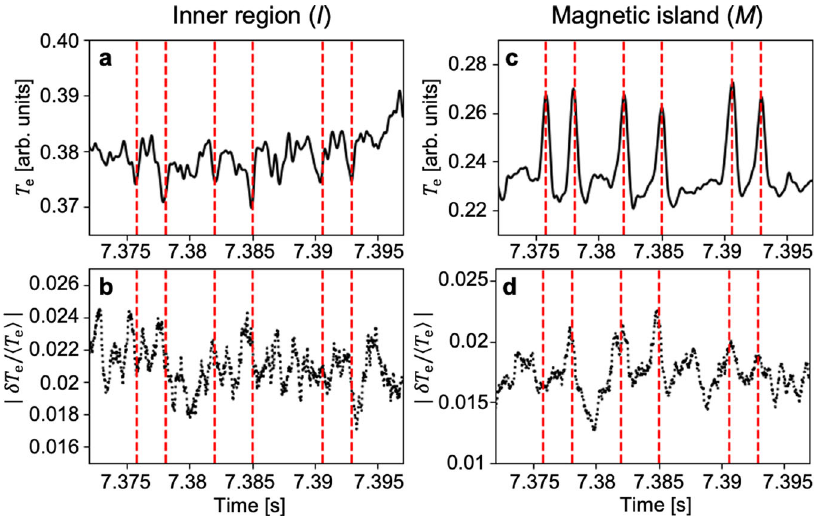
Fig. 4 Turbulence spreading into a magnetic island. a – d Low-pass fi ltered T e measurements ( a , c ) and the root-mean-square amplitudes of the normalized T e turbulence ( b , d ) in the inner region and the magnetic island region ( I , M ),